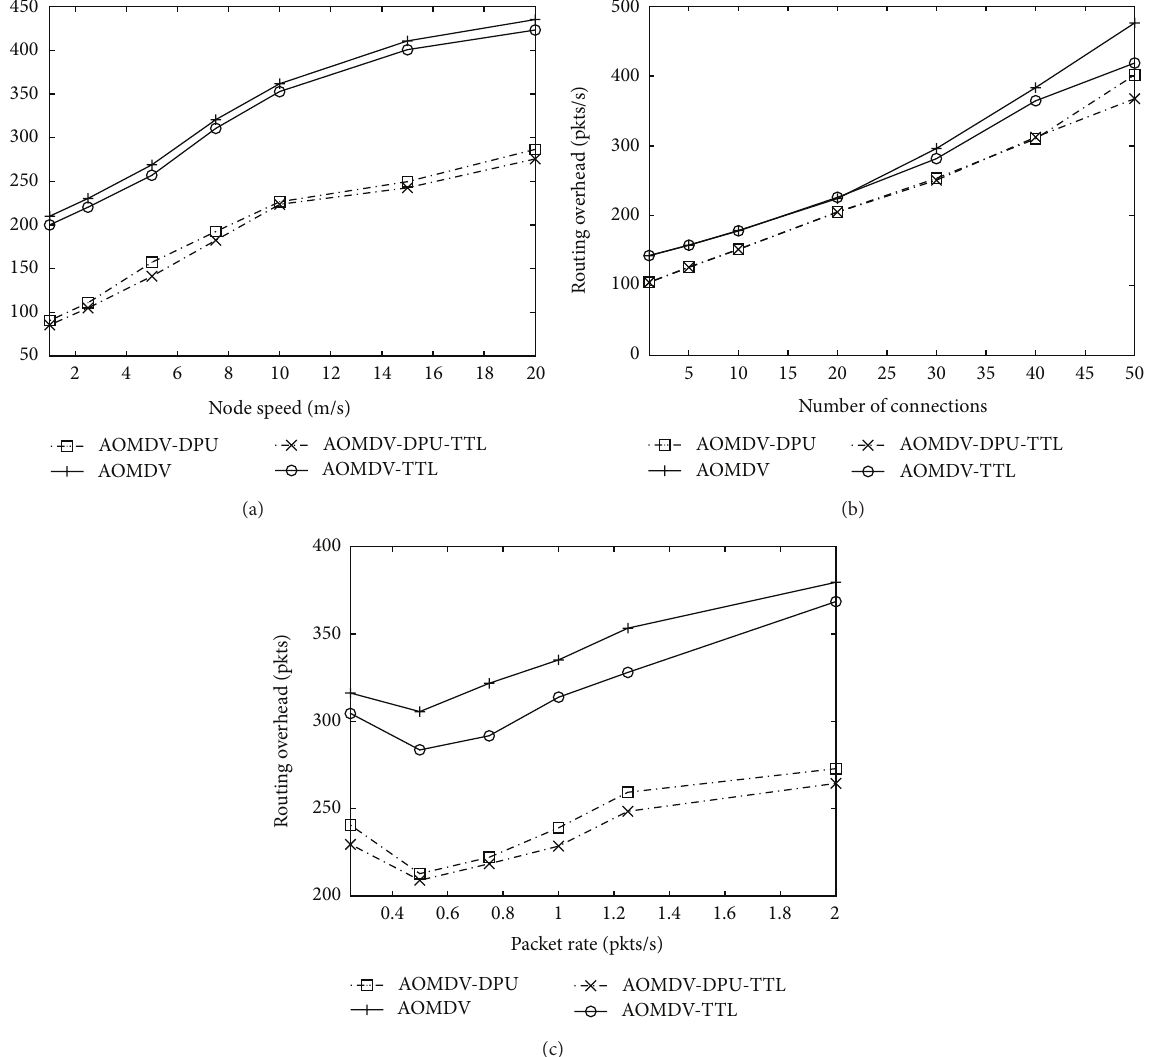
Figure 9: Overall routing overhead ( 𝑂 𝑅 ): (a) 𝑂 𝑅 versus node speed, (b) 𝑂 𝑅 versus number of connections, and (c) 𝑂 𝑅 versus packet generation